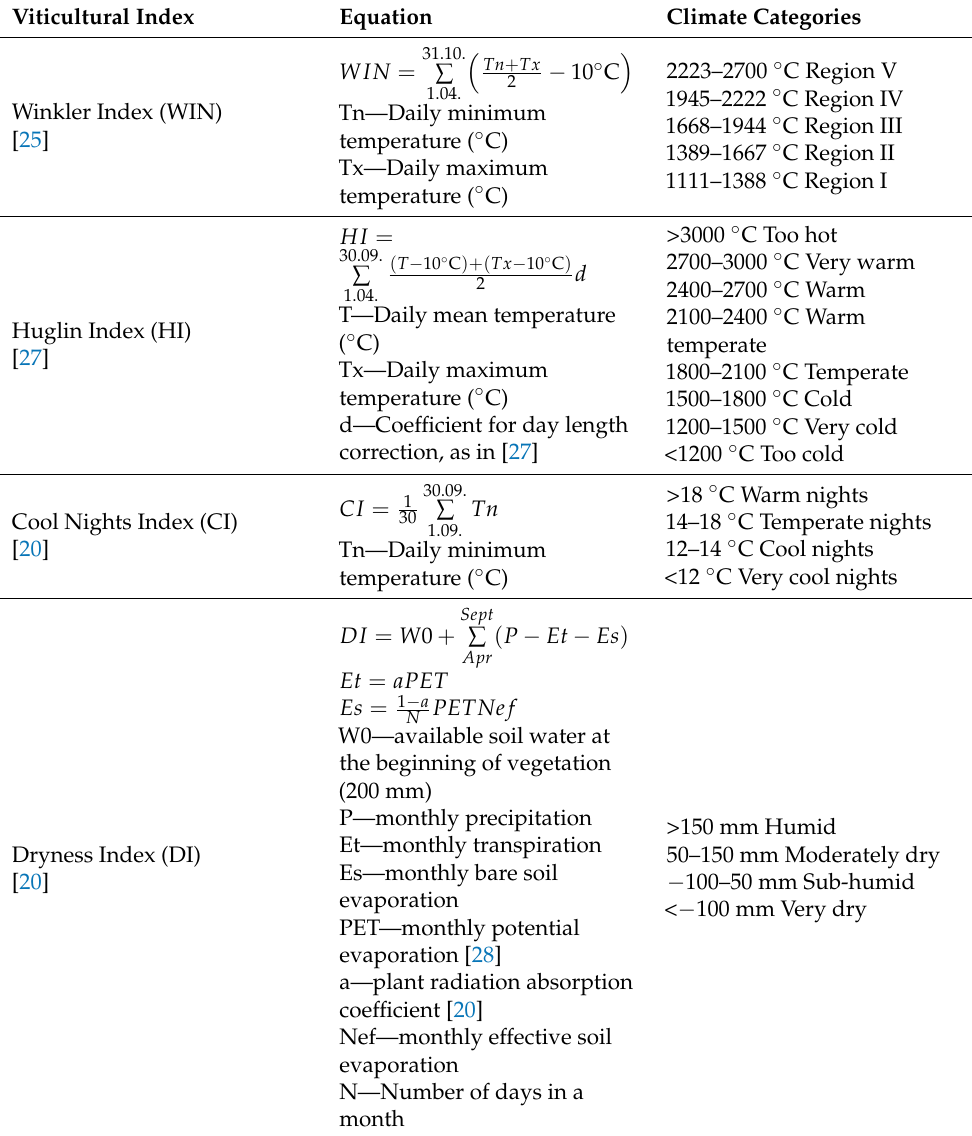
Table A2. Definition of viticultural indices and corresponding climate categories for the northern